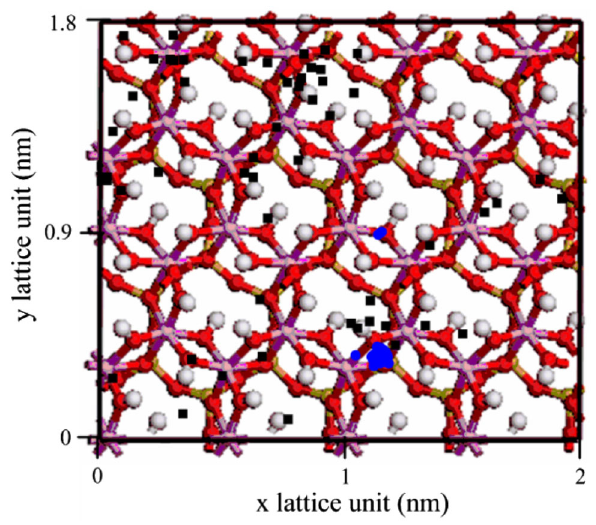
Fig. 3 Simulated motion of a CH 4 molecule and a water molecule in kaolinite. Color scheme: CH 4 , black; water,